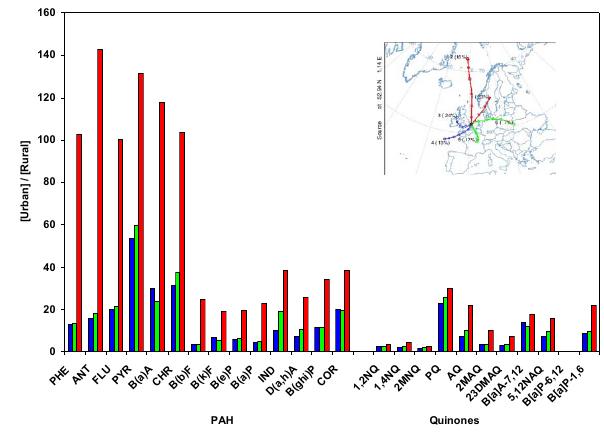
Fig 4. Winter ratio of compound concentrations measured at EROS, Birmingham, UK to species concentrations measured at Weybourne, UK. Blue – ratios determined using average concentrations of air masses travelling from mainland UK and London; Green – ratios determined using average concentrations calculated from air masses arriving from mainland Europe; Red – ratios determined using average concentrations calculated from air masses travelling from the North Sea